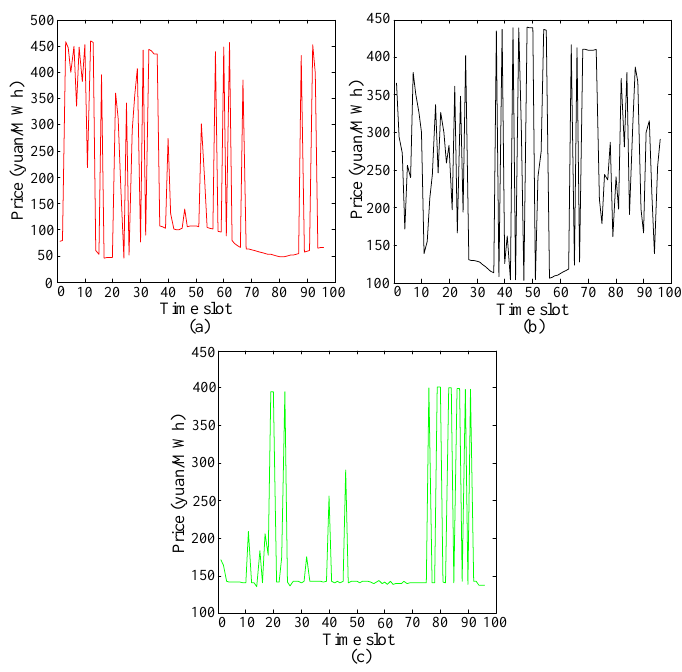
Figure 4. Bidding price on the day-ahead market: ( a ) wind farm; ( b ) solar power plant; ( c ) thermal power